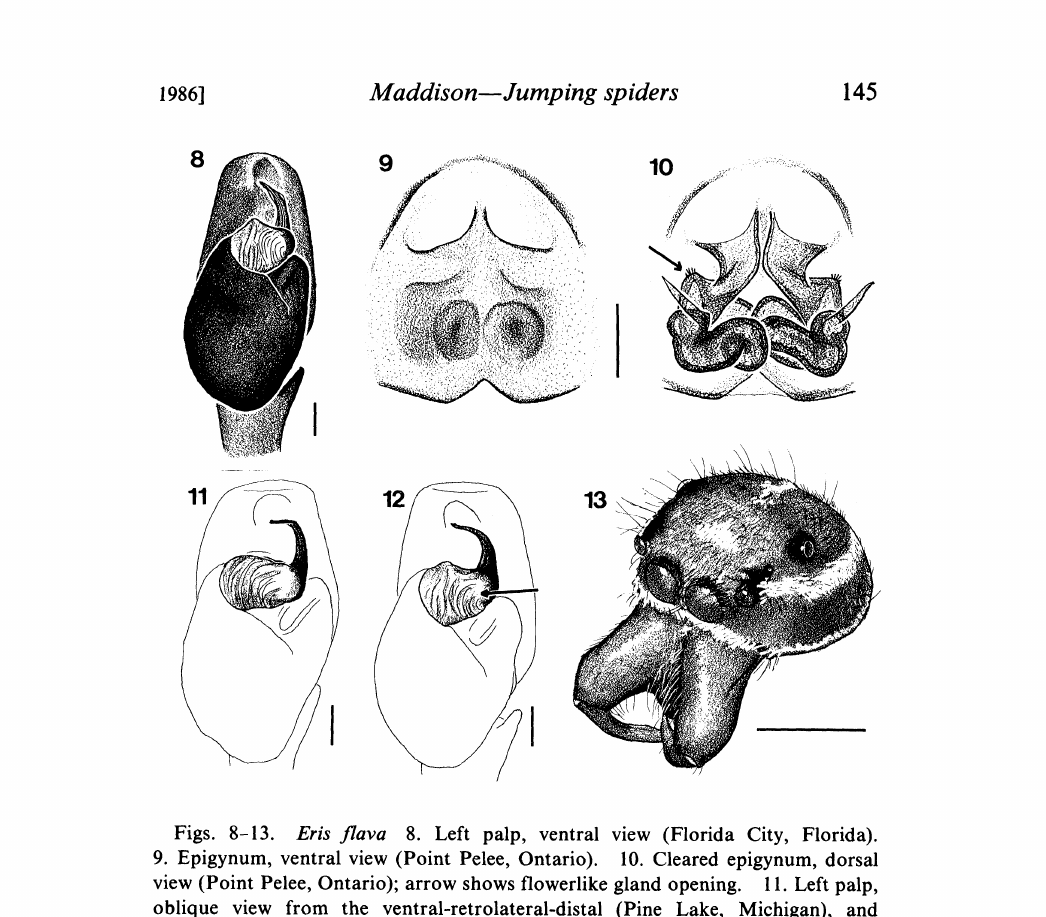
/ Figs. 8-13. Eris flava 8. Left palp, ventral view (Florida City, Florida). 9. Epigynum, ventral view (Point Pelee, Ontario). 10. Cleared epigynum, dorsal view (Point Pelee, Ontario); arrow shows flowerlike gland opening. 11. Left palp, oblique view from the ventral-retrolateral-distal (Pine Lake, Michigan), and 12. Same (Florida City, Florida); arrow shows curled wrinkles on retrolateral half of embolar base. 13. Male carapace and chelicerae (S. of St. Joseph, Michigan), oblique view. Scale bars 0.1 mm for 8-12; mm for